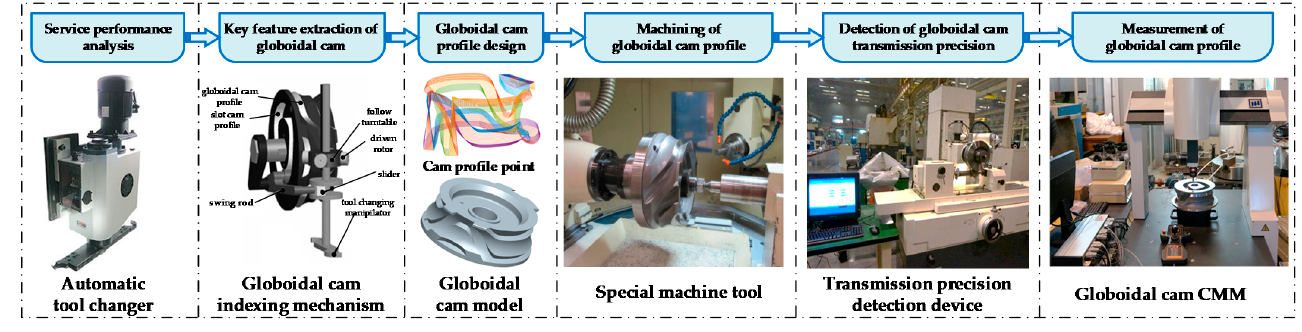
Figure 1. Schematic of globoidal cam design, manufacture and measurement integration.